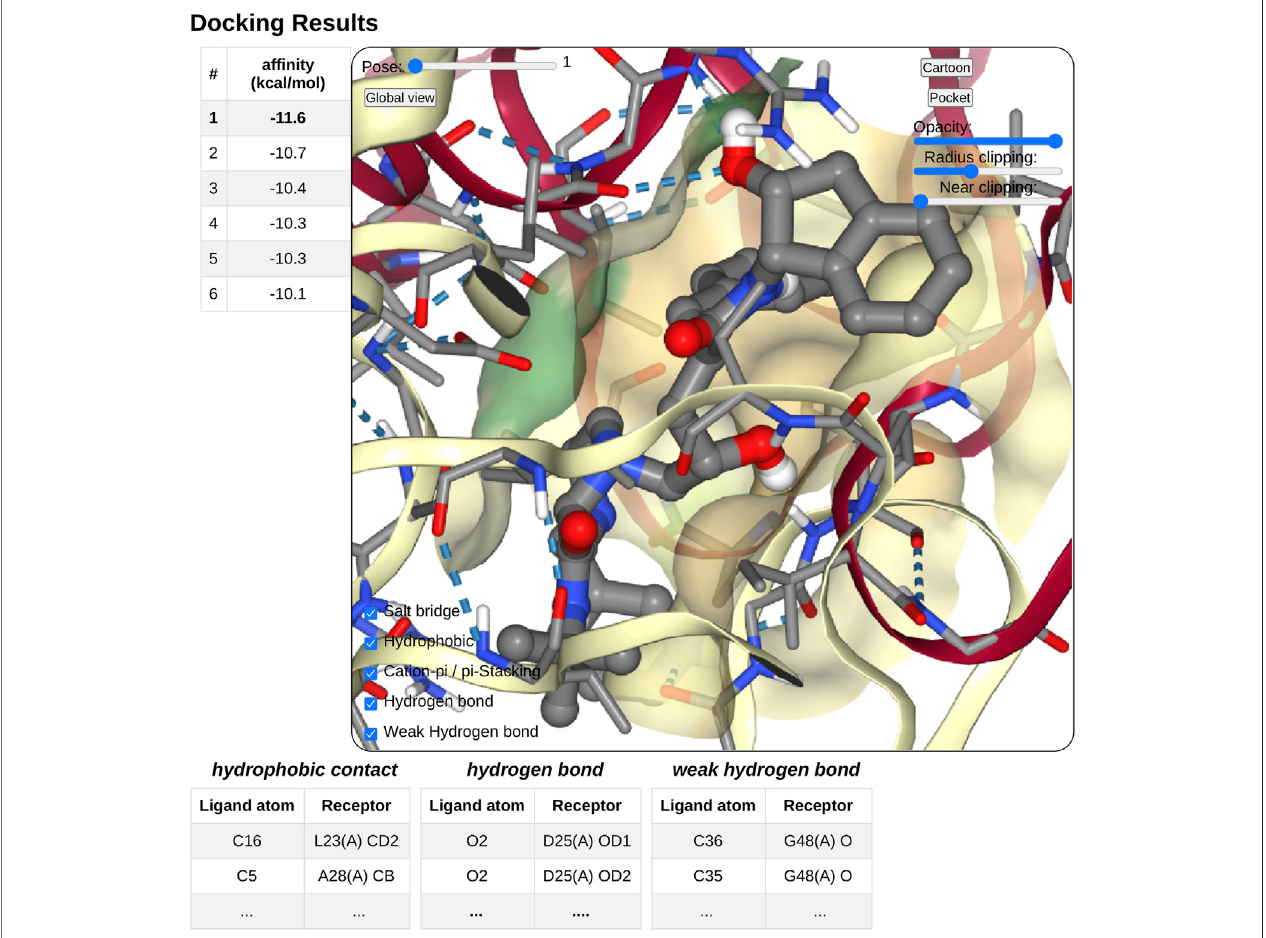
FIGURE4| Overview ofthedockingresultinterface. Oncedockingcomputationhasbeen complete, thedockingposestructuresincomplexwiththereceptorwill be displayed in 3D in a NGL stage. The af fi nity of each poses will be displayed as a table in a right panel, clicking on a table row will display the selected pose in the NGL stage. Receptor appearance and ligand-receptor interactions can be personalized by the user. Tables of ligand – receptor interactions will be displayed at the bottom of the NGL stage, clicking on a contact will highlight it in the NGL stage.